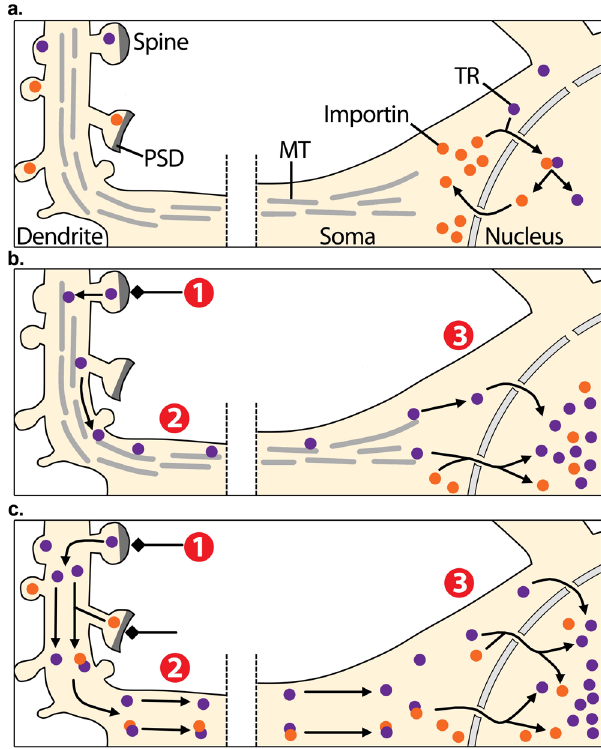
Figure 1. Synapto-nuclear translocation of transcription regulators. a ) In non-stimulated conditions, transcription regulators (TR, purple dots) are localised into distant dendrites as well as at the perinuclear zone. Some TRs are transported from the cytoplasm to the nucleus by importins (orange dots). Importins are also distributed across distant dendrites and at the postsynaptic density (PSD). b, c ) Excitatory inputs that stimulate synapses (1) are believed to activate TRs, which are then transported to the soma along the neuron (2) through microtubule-based active transport b ) or by passive diffusion c ). Excitatory inputs are also proposed to activate importins at the PSD, which then associate to synaptic cargoes and facilitate their synapto-nuclear translocation c ). Therefore, this model predicts that synaptic activity triggers the accumulation of TRs from distant synapses in the nucleus, promoting the induction of gene expression programs